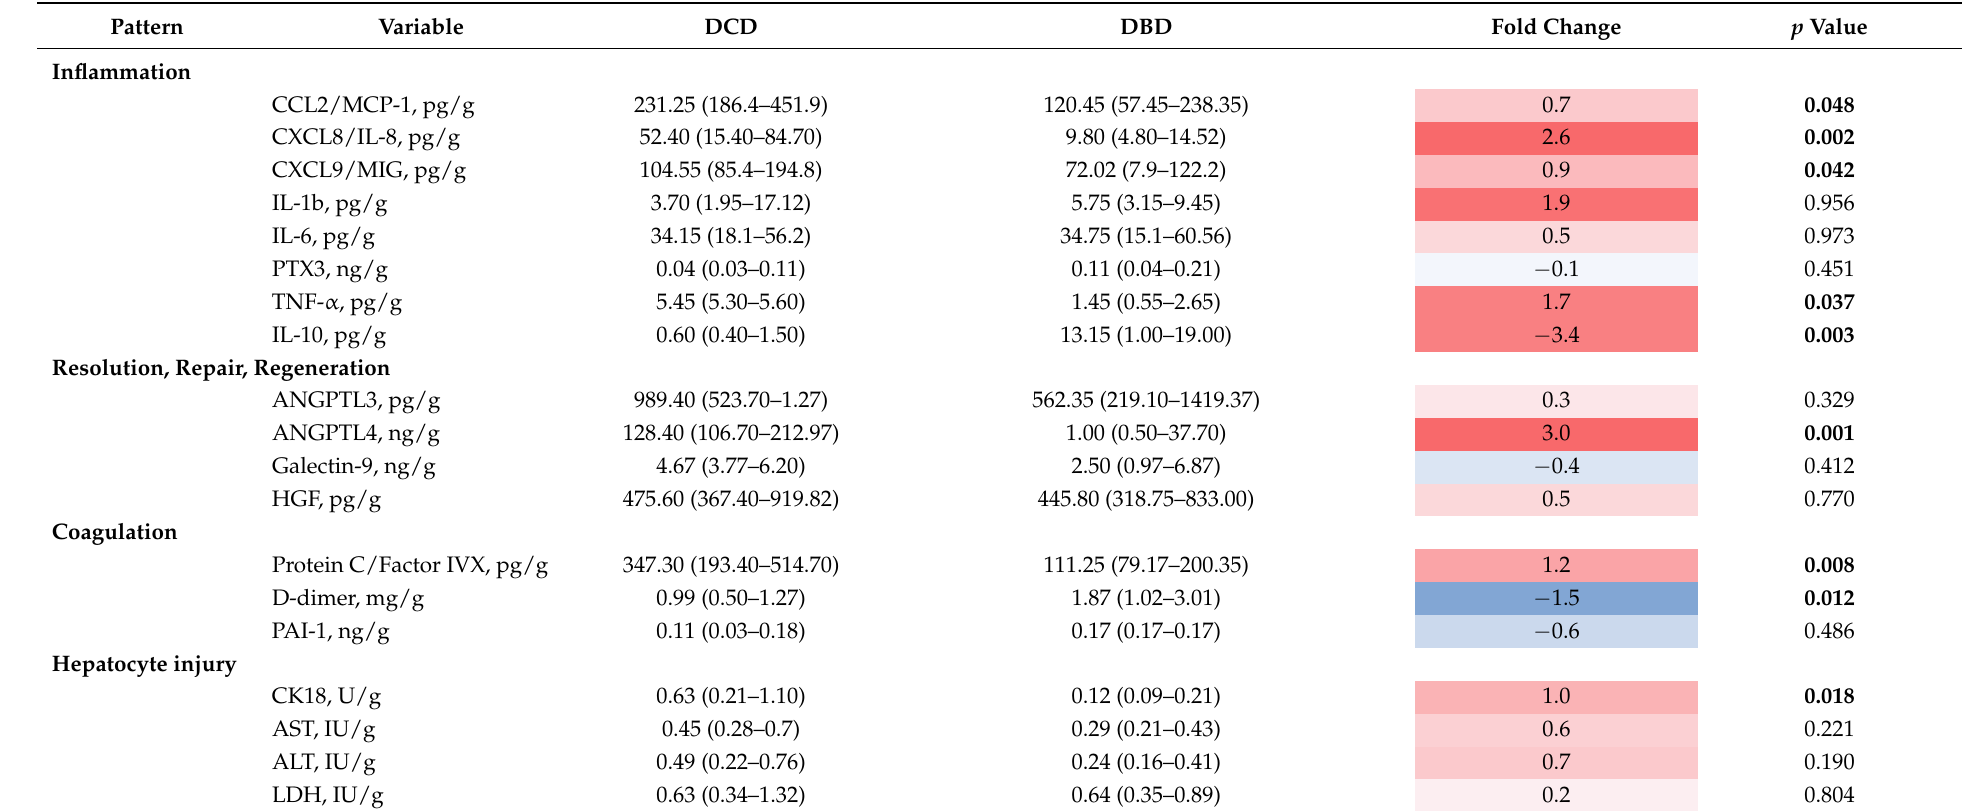
Table 2. Differences in the molecular profile of effluent fluids collected from DCD and DBD liver grafts. Variables were assessed by means of routine laboratory testing, gas analysis, and immunoassays. Median (25–75) is shown for each variable. Fold change was calculated by log2-trasforming the ratio of the mean of DCD over the mean of DBD for each analyte; a color-based scale was used to facilitate data visualization. Statistical significance between groups was investigated with non-parametric Wilcoxon